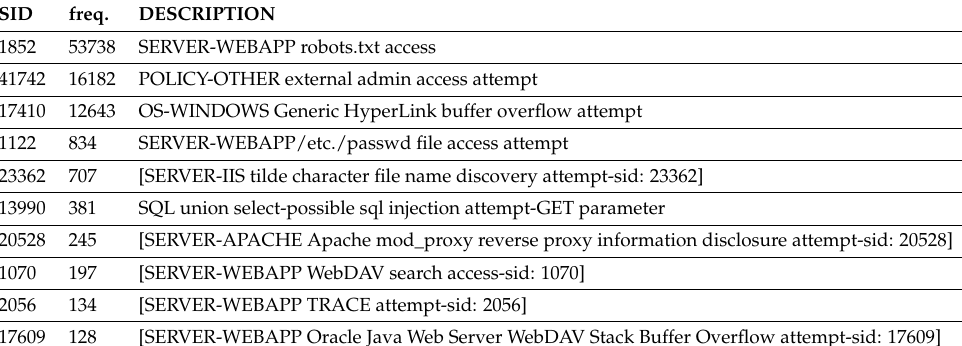
Figure 4. Histogram sorted to rank (log scale). Table 7. SID and frequency of alerts